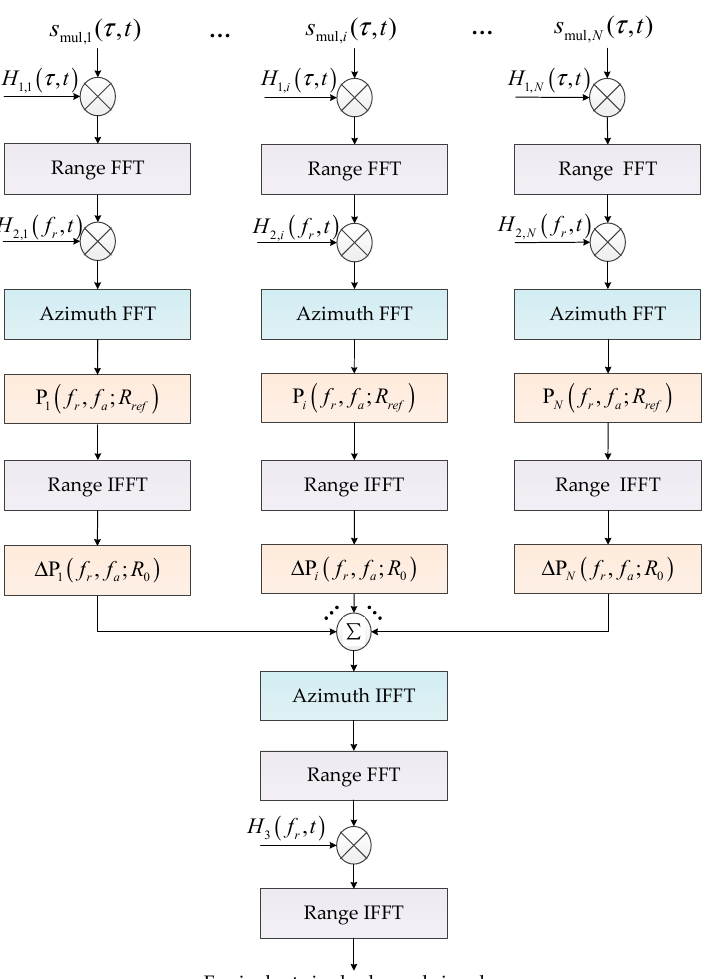
Figure 11. Flowchart of the proposed multichannel reconstruction method based on AHRE . The time-varying phase error compensation in each azimuth channel is implemented